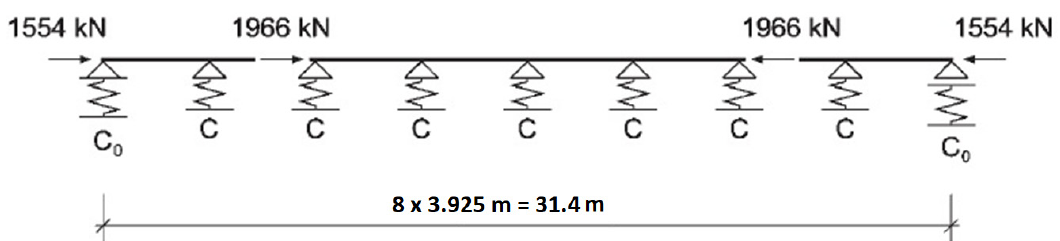
Figure 7. Example 2: the scale factor Ω ( x ). Utilization factor U N+M = 1.0.